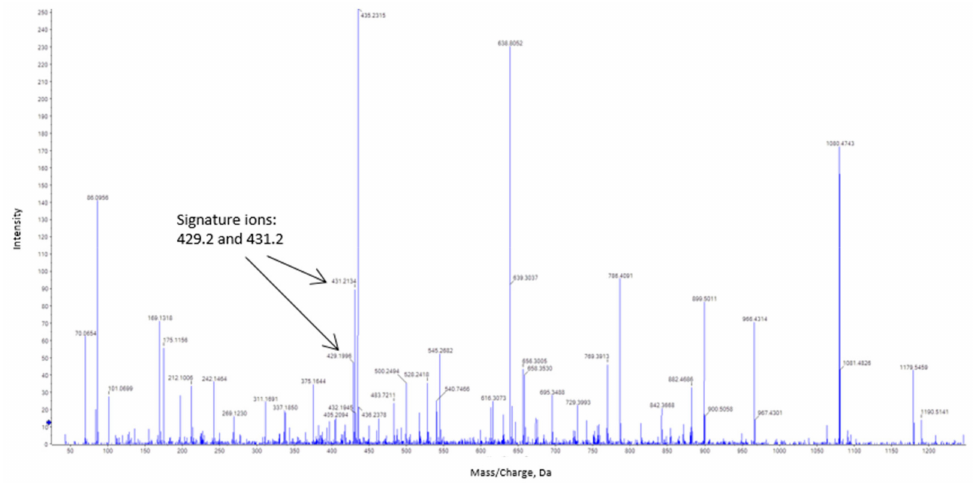
Tandem mass spectrometry (MSMS) fragmentation of peptides labeled with N-[6-(biotinamido)hexyl]-3 (cid:48) -(2 (cid:48) -pyridyldithio)propionamide (biotin-HPDP) following nanoliquid chromatography (nLC)-MSMS analysis of in-gel trypsin digestion of bovine catalase. The typical signature ions obtained from biotin-labeled catalase peptide are indicated by arrows. The amino acid sequence of the labeled peptide is L 366 GPNYLQIPVNC 377 PYR 380